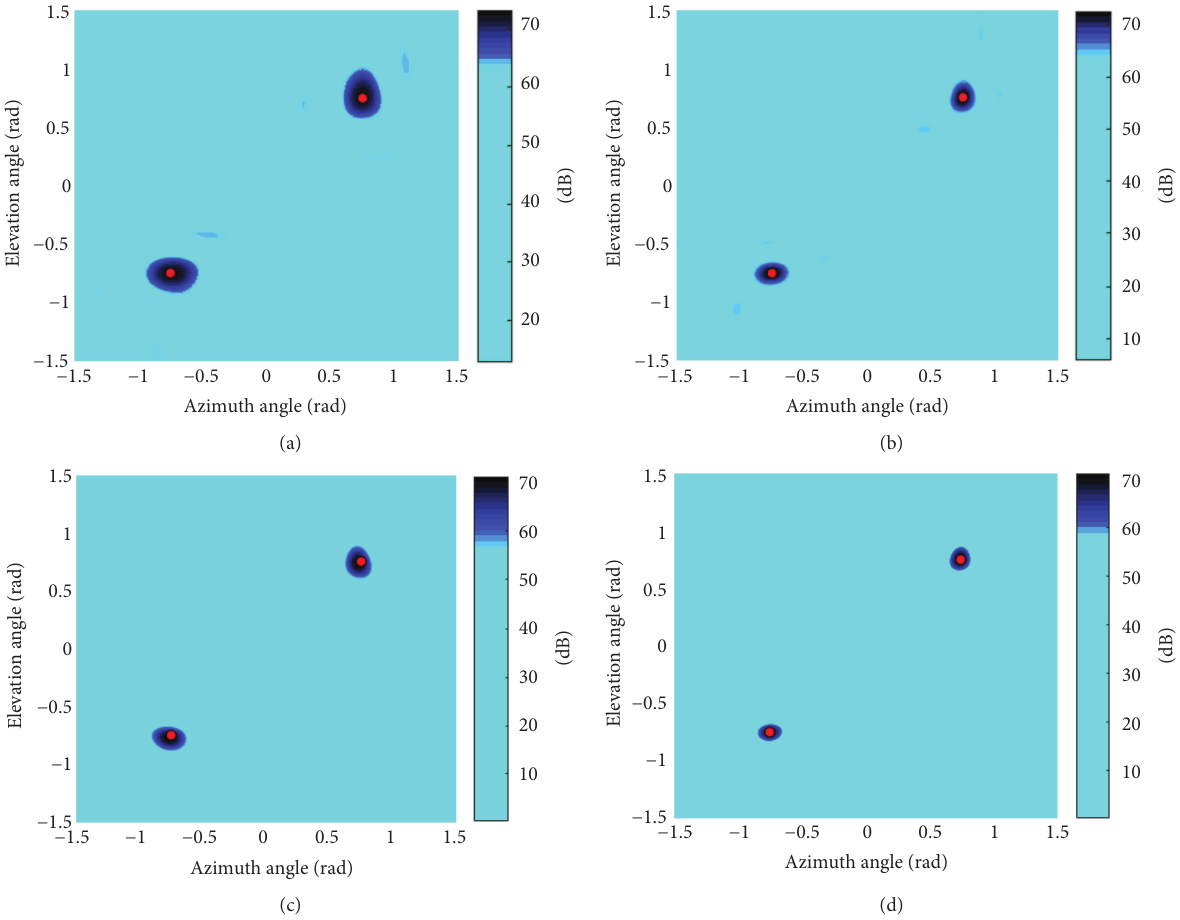
Figure 9: Acoustic source maps of partition array with different frequencies: (a) 800Hz; (b) 1200Hz; (c) 2000Hz; (d)